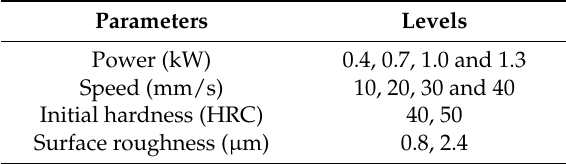
Table 1. Scratching parameters of the process and their